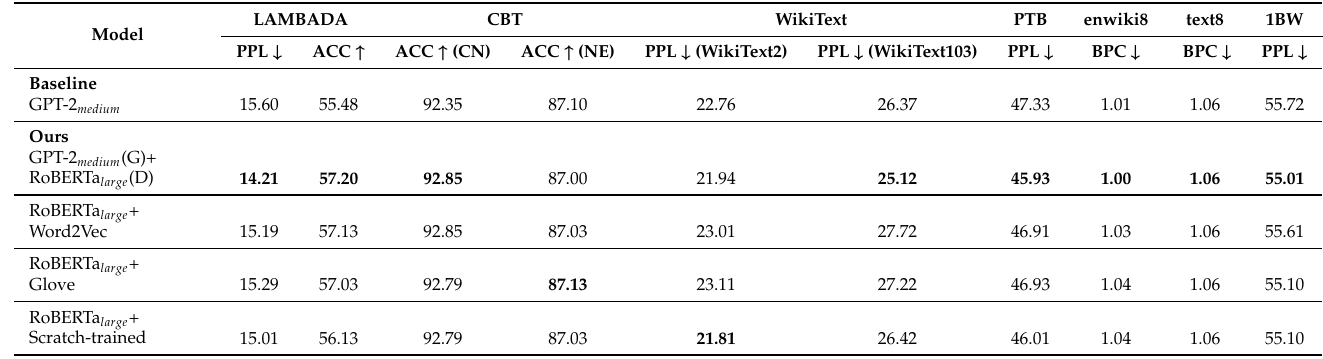
Table 6. After 156 minibatch-sized EvoText sessions, we evaluated the performance of various natural language understanding models (D) with or without pretrained word embeddings and the same language generation model (GPT medium ) on 7 natural language processing tasks using ZERO-SHOT. Each model was tested five times on each task, and the results were